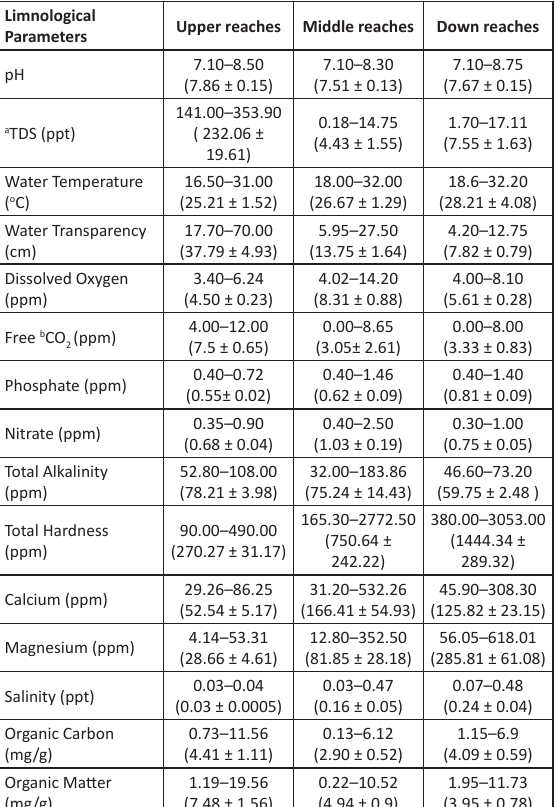
Table 2. Limnological variables in